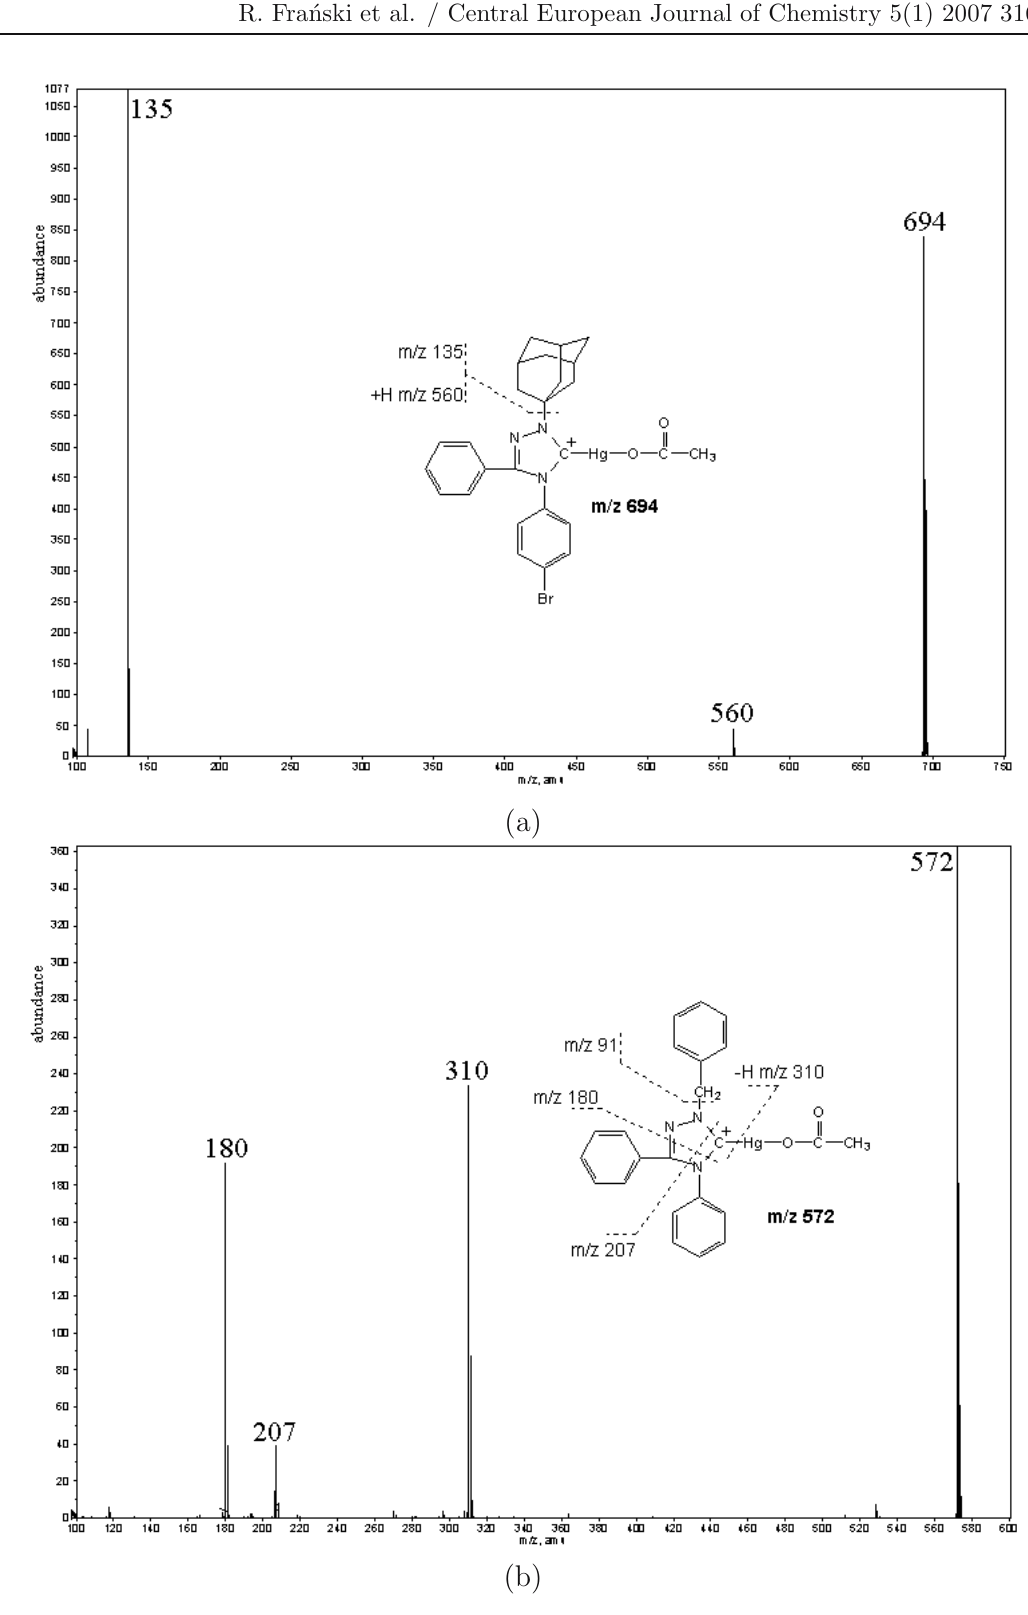
Fig. 1 MS/MS spectrum of [ 1 +HgOOCCH 3 ] + (a, collision energy 35 eV) and [ 2 +HgOOCCH 3 ] + (b, collision energy 40 eV, for clarity shown from m/z